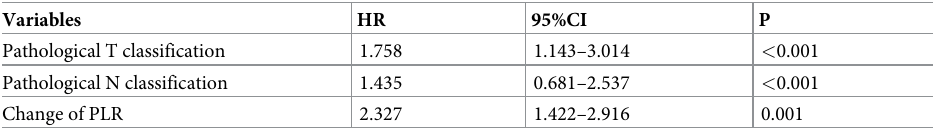
Table 5. Factors associated with postoperative survival in the multivariate analyses.